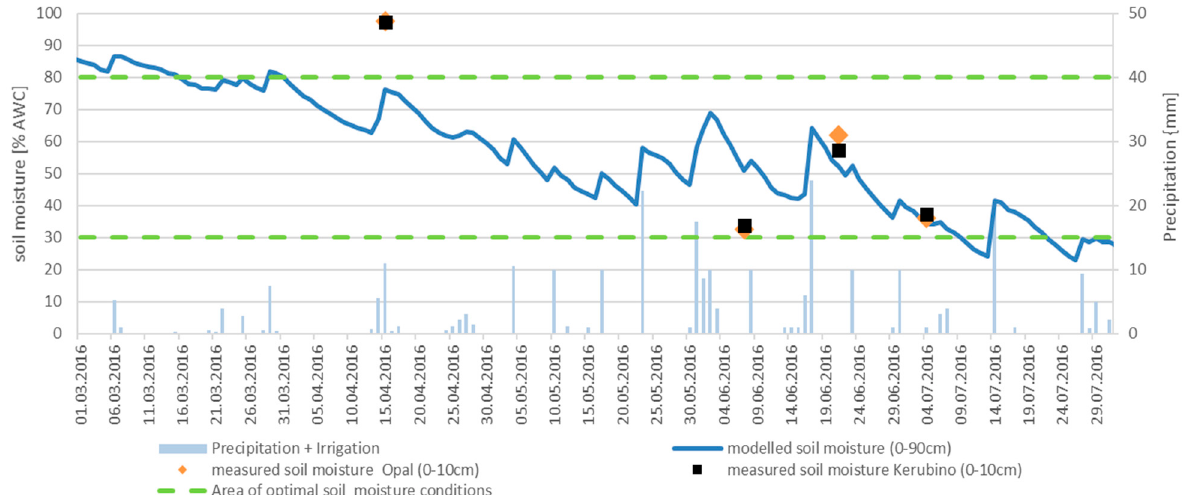
Figure 7. Modeled and measured soil moisture [% AWC] of irrigated winter wheat plots Opal and Kerubino and precipitation [mm] in the period March to July 2016.